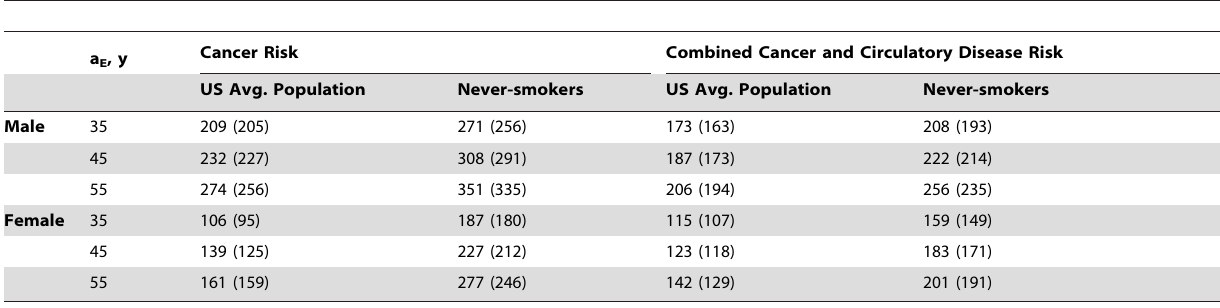
Table 2. Demographic Specific Solar Minimum Safe Days in deep space, which are defined as the maximum number of days with 95% CL to be below the NASA 3% REID limit for males and females at different ages at exposure, a E